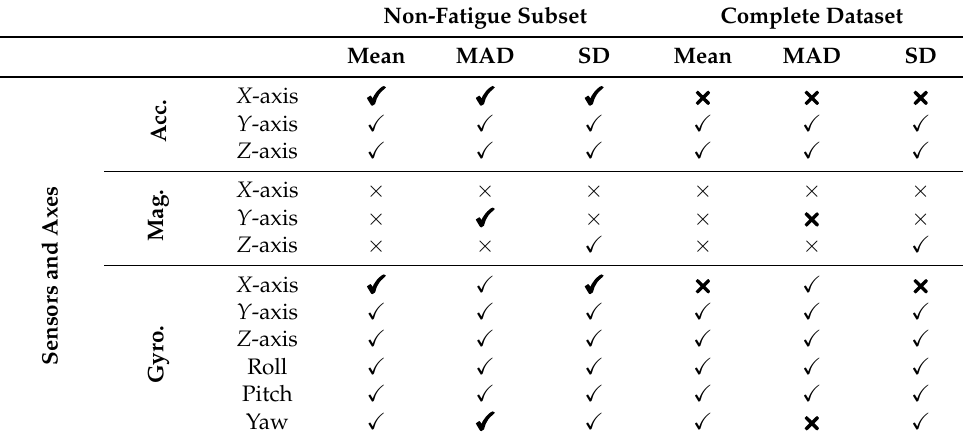
Table 5. Table of the significant ( (cid:88) ) and insignificant ( × ) features extracted from both the non-fatigue subset and complete dataset; the changed features are in highlighted